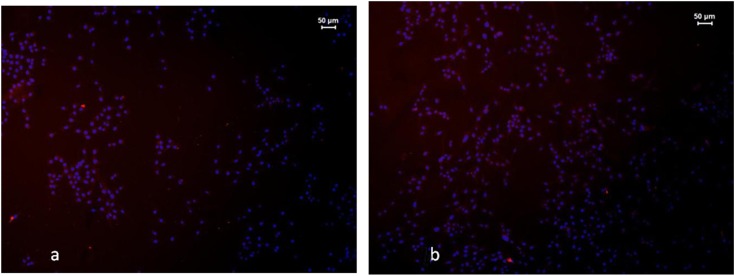
a. Positive expression of S-100 in induced Schwann cells. b. Positive expression of GFAP in induced Schwann cells.